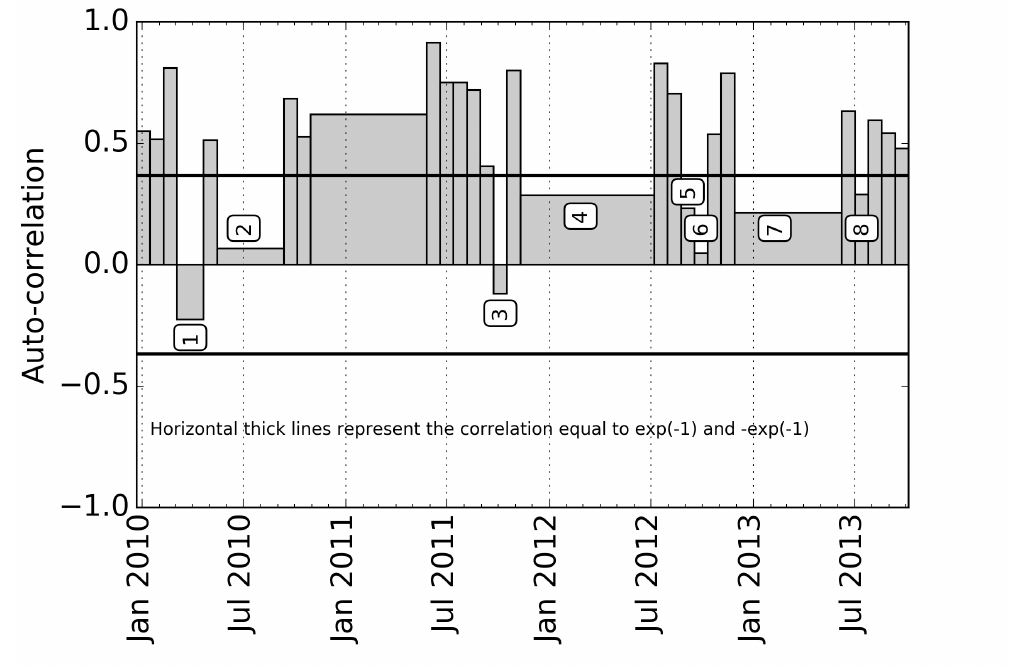
Figure 12. Auto-correlation among two consecutive SM images of RADARSAT-2 at a spatial resolution of 1000